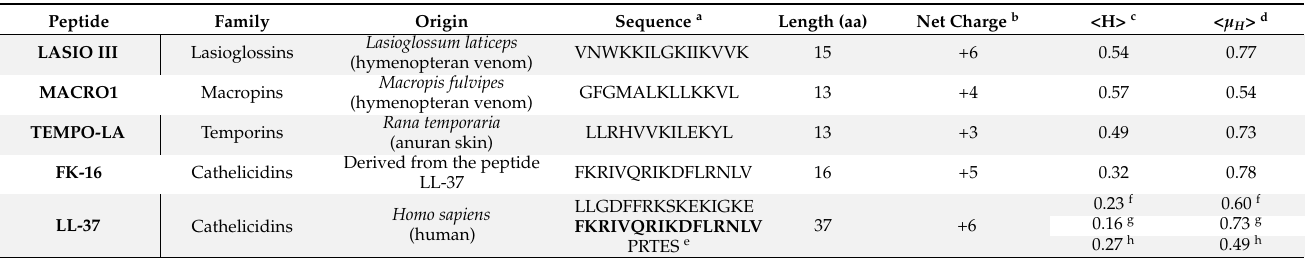
Table 1. Properties of selected natural anticancer peptides used in the